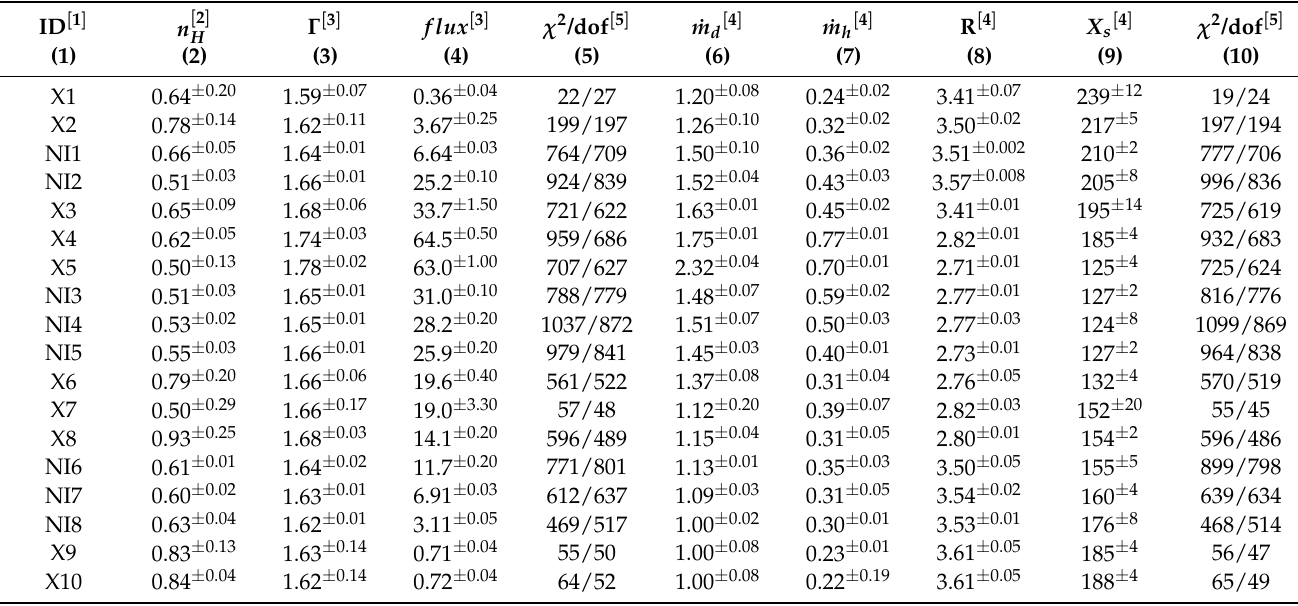
Table 2. Model-fitted parameters for Swift/XRT, combined NICER+MAXI/GSC and